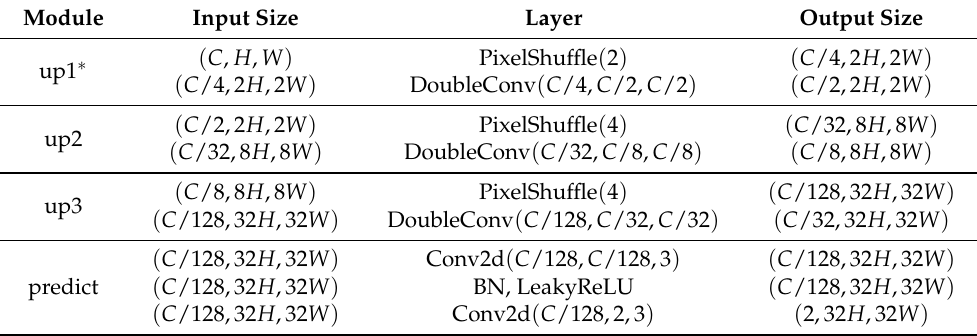
Table 2. Layers of the prediction head. We use the PixelShuffle layer [68] for upsampling. The up1 ∗ layer is only applied when the last feature map size is 1/32 of the original resolution in ablation study. DoubleConv means two convolutional layers following by batch normalization and ReLU activation